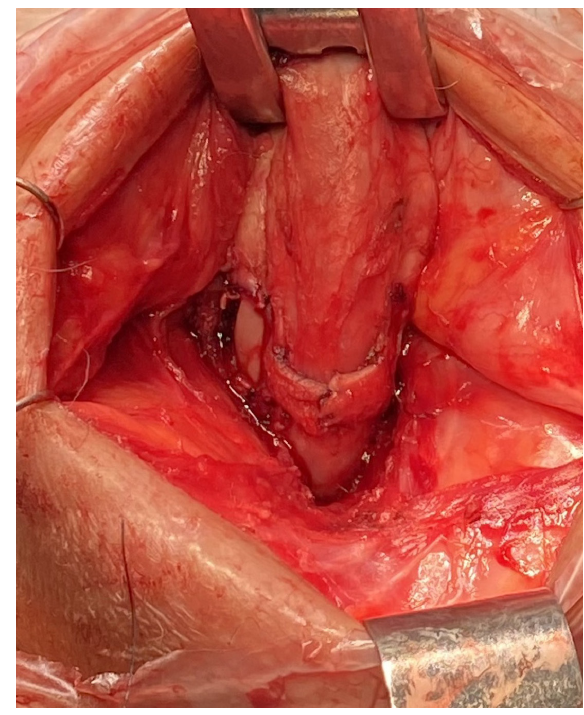
Figure 3. Bovine pericardium flap covering cavernosal